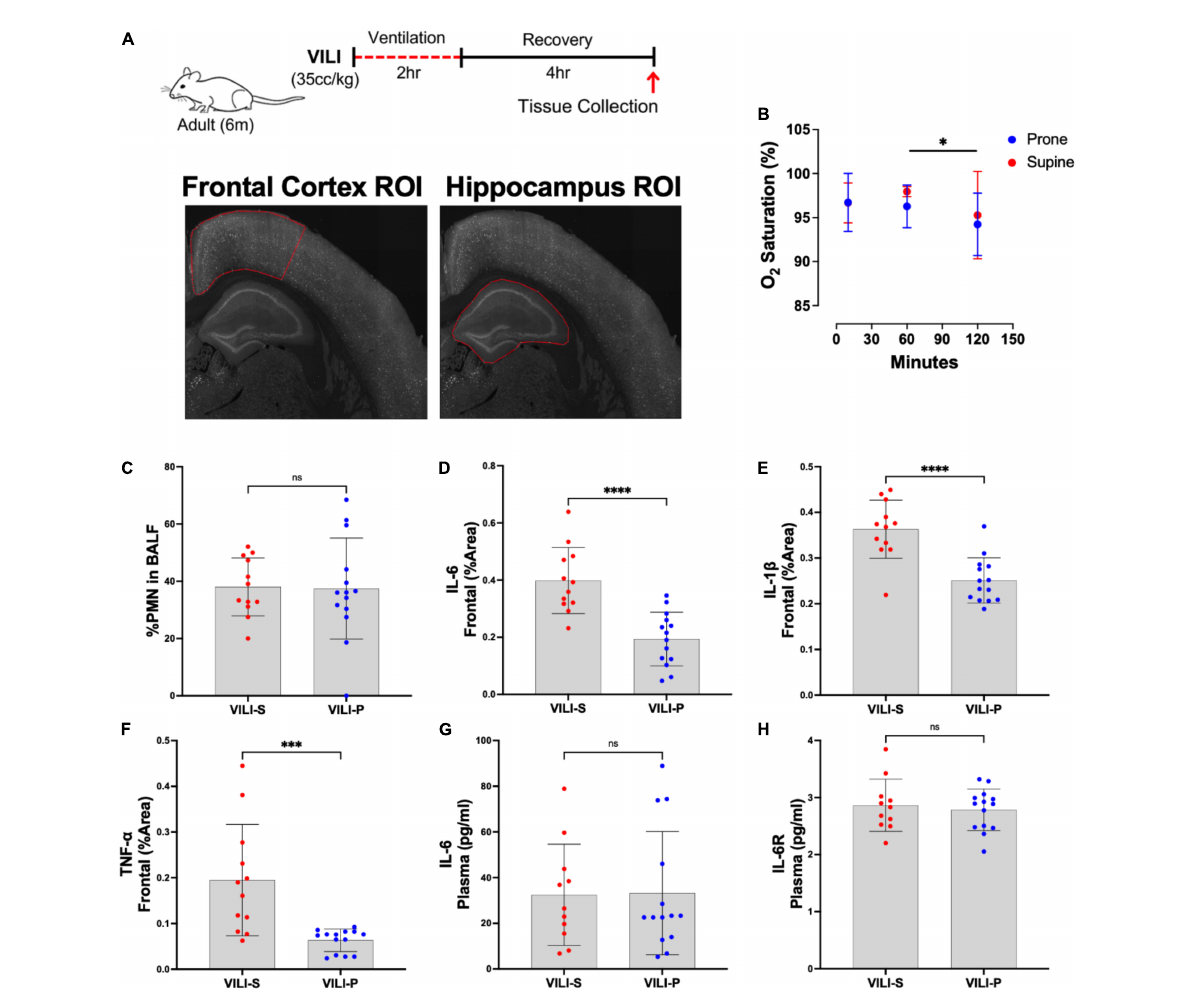
FIGURE1 Prone position during acute ventilator induced lung injury (VILI) decreases neuronal inflammation in the frontal cortex. (A) Schematic of experimental timeline and representative regions of interest (ROIs) in the frontal cortex and hippocampus. (B) Oxygen saturation between prone and supine position did not significantly differ at any time point ( p > 0.05). Post hoc tests revealed oxygen saturation at 120 mins (the end of the mechanical ventilation period) was significantly lower than at 60 min ( p = 0.0328). (C) Quantification of lung inflammation measured by the percentage of polymorphonuclear cells (PMNs) in bronchoalveolar lavage fluid (BALF) was not significantly different between prone and supine groups, indicating that differential lung injury is not driving neuronal dysfunction. (D–F) Prone positioning significantly reduced cortical inflammatory cytokines (IL-6, IL-1 β , TNF- α ) as compared to supine positioned mice ( p < 0.001). (G,H) Plasma IL-6 and IL-6 receptor (IL-6R) quantities did not differ between groups. Group sample sizes for all analyses were prone ( n = 14) and supine ( n = 12). Data are expressed as mean ± SD. ∗ p < 0.05, ∗∗∗ p < 0.001, ∗∗∗∗ p <